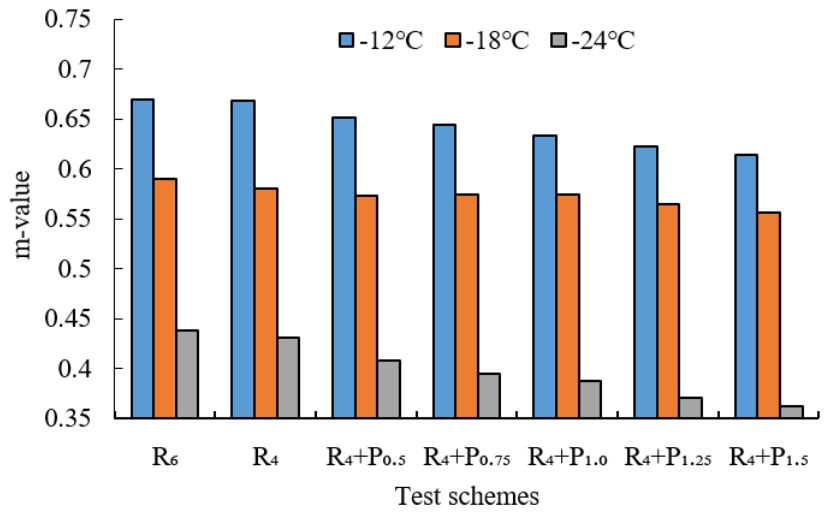
Figure 16. m-value of PPA – SBR and LH – 90# asphalt.